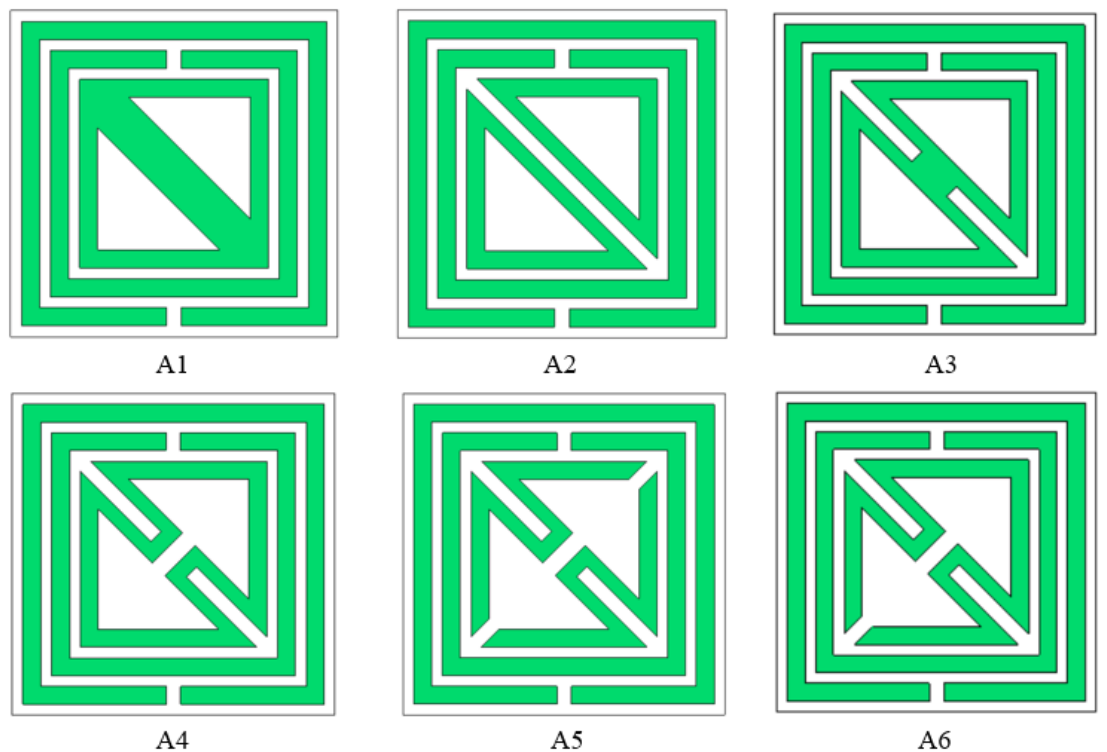
Figure 4. Selection stage for the proposed metamaterial unit cell. (A1) dual square rings with diagonally connected inner ring; (A2) Split the inner ring in diagonally; (A3) inductively coupled in the inner rings; (A4) diagonally split for closed inner ring; (A5) cut the inner ring at the edge of the corner; (A6) connected one edge of the inner ring.